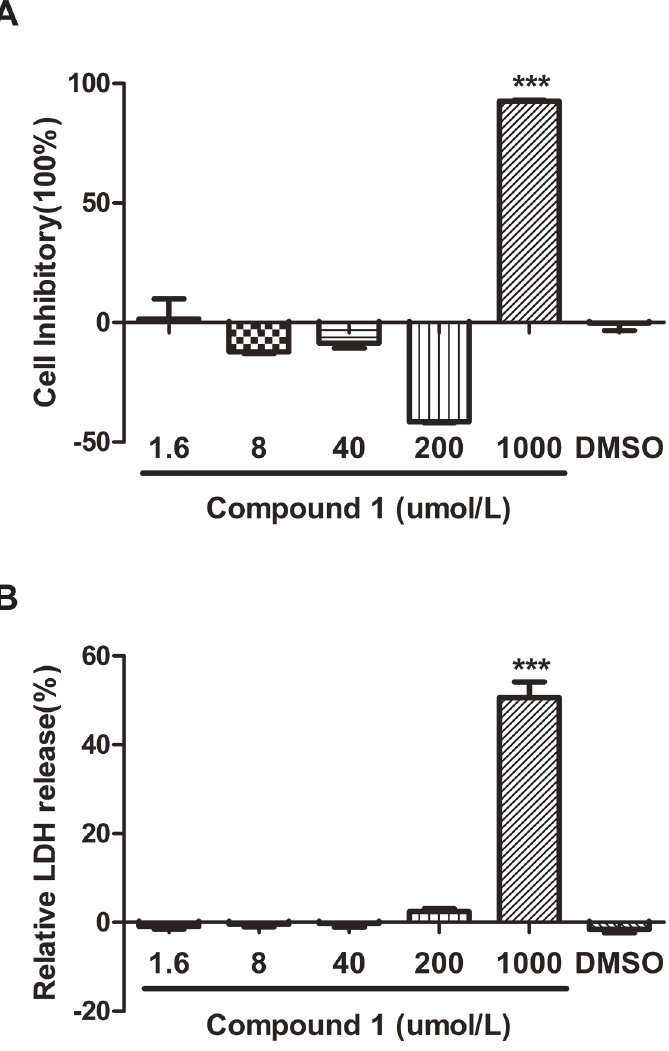
control and results were as the mean ± S.E.M., n = 6, *** P < 0.001, compared with the DMSO